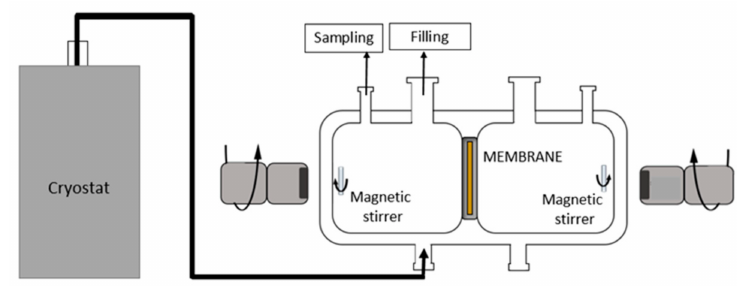
Figure 2. Schematization of the pertraction cell used for our experiments